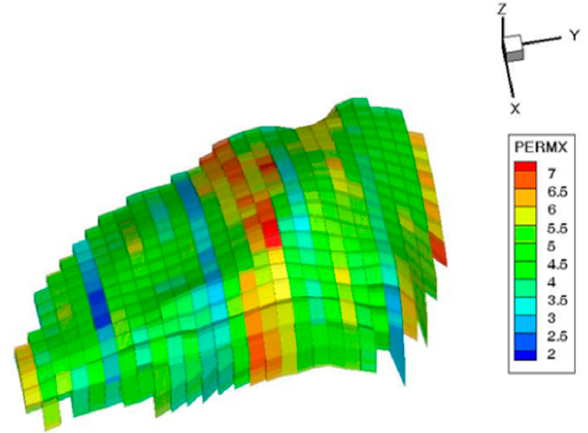
Figure 4. The log permeability field with a relatively large cell size generated by GenPack.